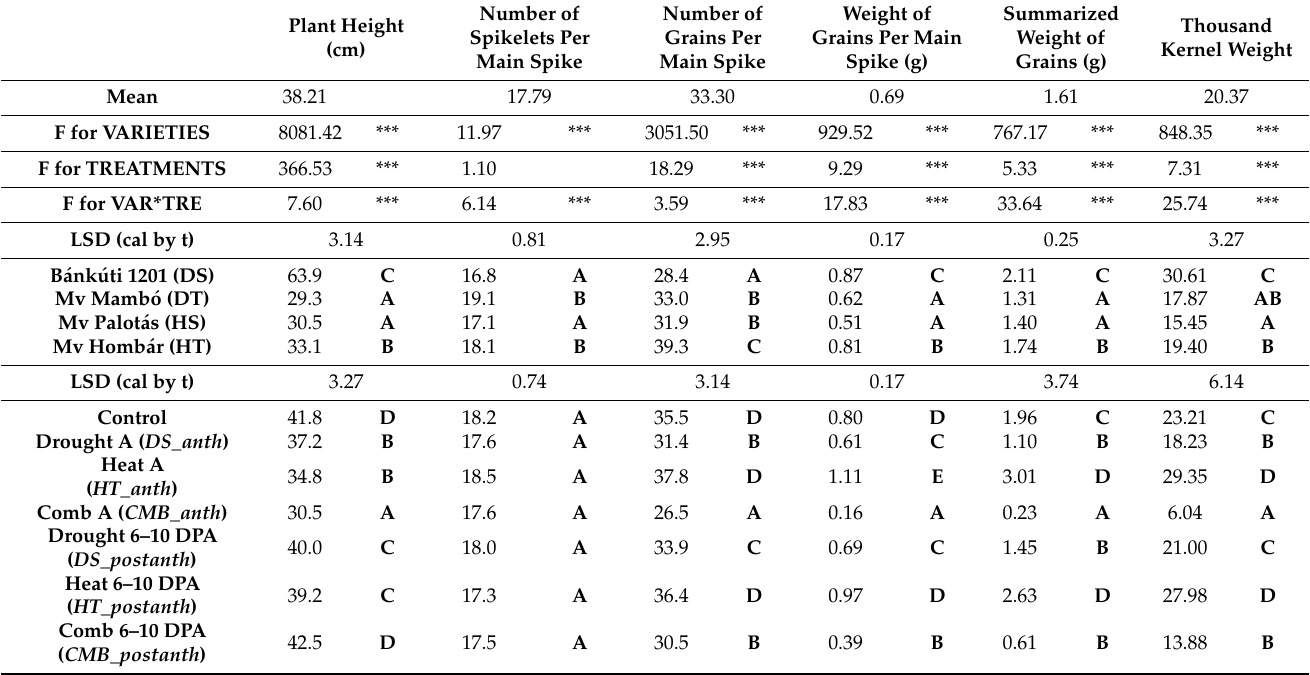
Table 1. The alteration of physiological parameters caused by the different abiotic